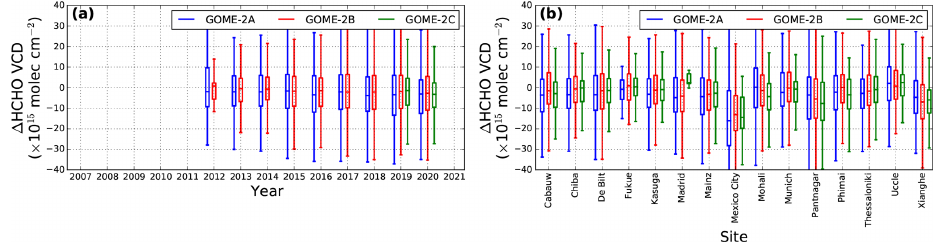
Figure 25. Comparison of total column HCHO between ground-based MAX-DOAS and GOME-2 observations. Data are sorted by year in panel (a) and measurement site in panel (b)